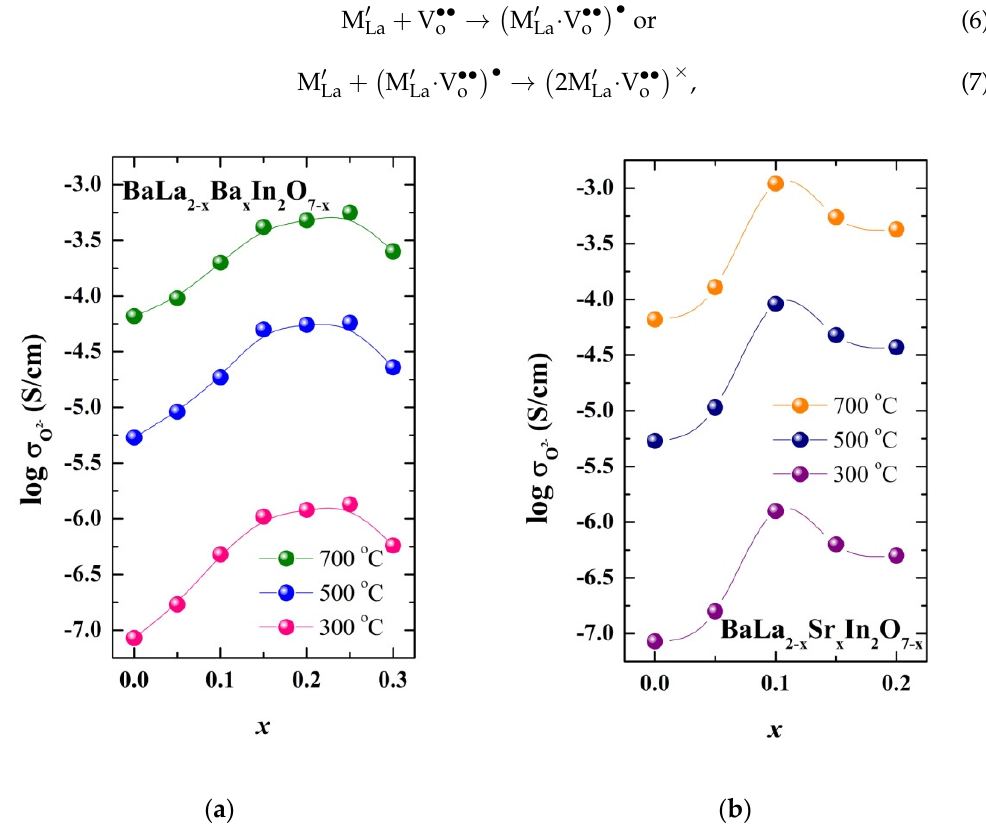
Figure 7. The concentration dependencies of oxygen ion conductivity at 300, 500, and 700 °C for the solid solutions BaLa 2 − x Ba x In 2 O 7 − 0.5 x ( a ) and BaLa 2 − x Sr x In 2 O 7 − 0.5 x ( b ).